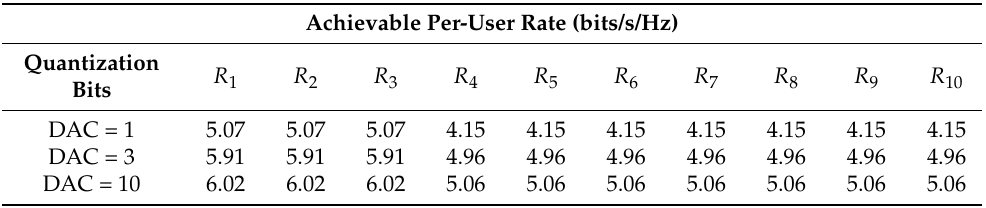
Table 3. The Achievable Per-User Rate for proposed algorithm, for 1 (cid:54) n (cid:54) 3, ω k = 0.5, else ω k = 1. Achievable Per-User Rate (bits/s/Hz)